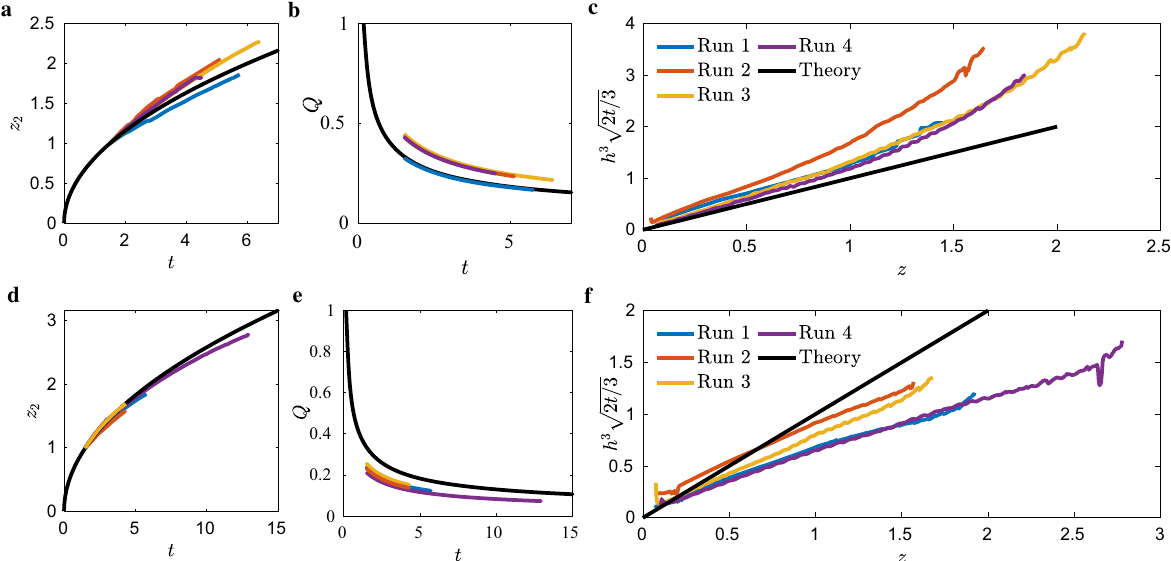
Fig. 5 Reduced ICF-1 test cell drain data. Draining from small-end a – c and big-end d – f . a and d plot advancing bulk meniscus location z 2 ( t ), b and e volumetric fl ow rate Q ( t ), and c , f the self-similar time-averaged interface height pro fi le h 3 (black) of Eqs. (7), (6), and (5),